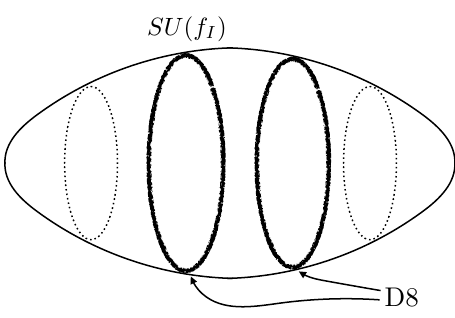
Figure 5 . Schematic representation of the compactification space M 3 (see also [130, 132]). It looks like an American football, with stacks of D8-branes at particular positions wrapping the angular S 2 . A stack of f I branes provides an SU( f I ) symmetry at low